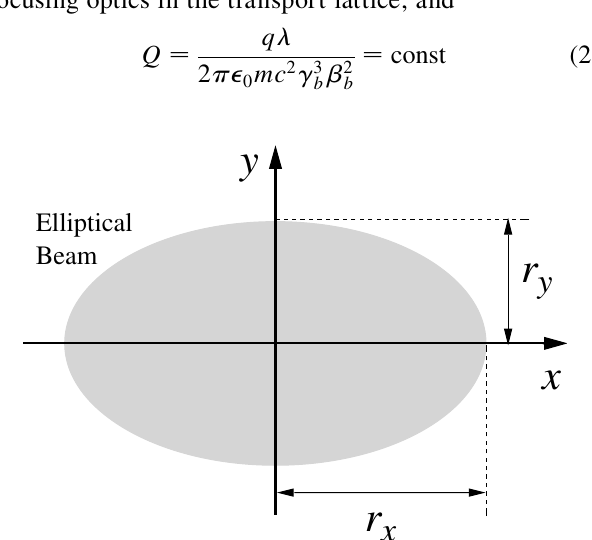
FIG. 1. Transverse cross section of an elliptical beam cen- tered at x (cid:1) y (cid:1) 0 with envelope radii r y axes and uniform charge density within the